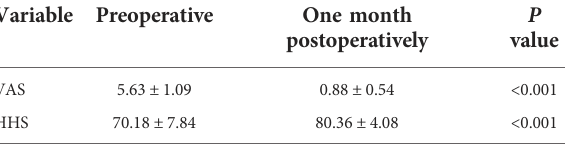
VAS, Visual Analogue Scale; HHS, The Harris Hip Score.